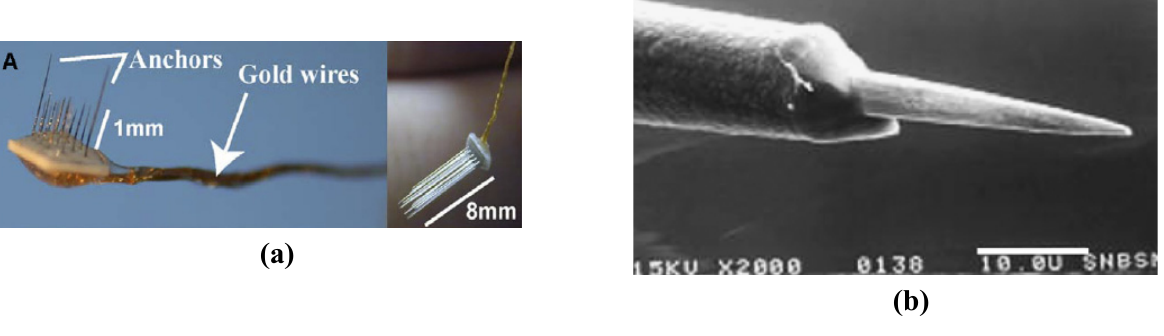
Figure 2. (a) Floating multi-electrode array with short and long electrodes. Reprinted from [43] with permission from Elsevier; (b) An SEM micrograph of an electrode used in the floating multi-electrode array (FMA) pretreated with A-174 Silane before being insulated with 3mµ of Parylene-C. The tip was exposed by a non-thermal ablation technique using a dual beam Eximer laser system. Reprinted from [63], with permission from